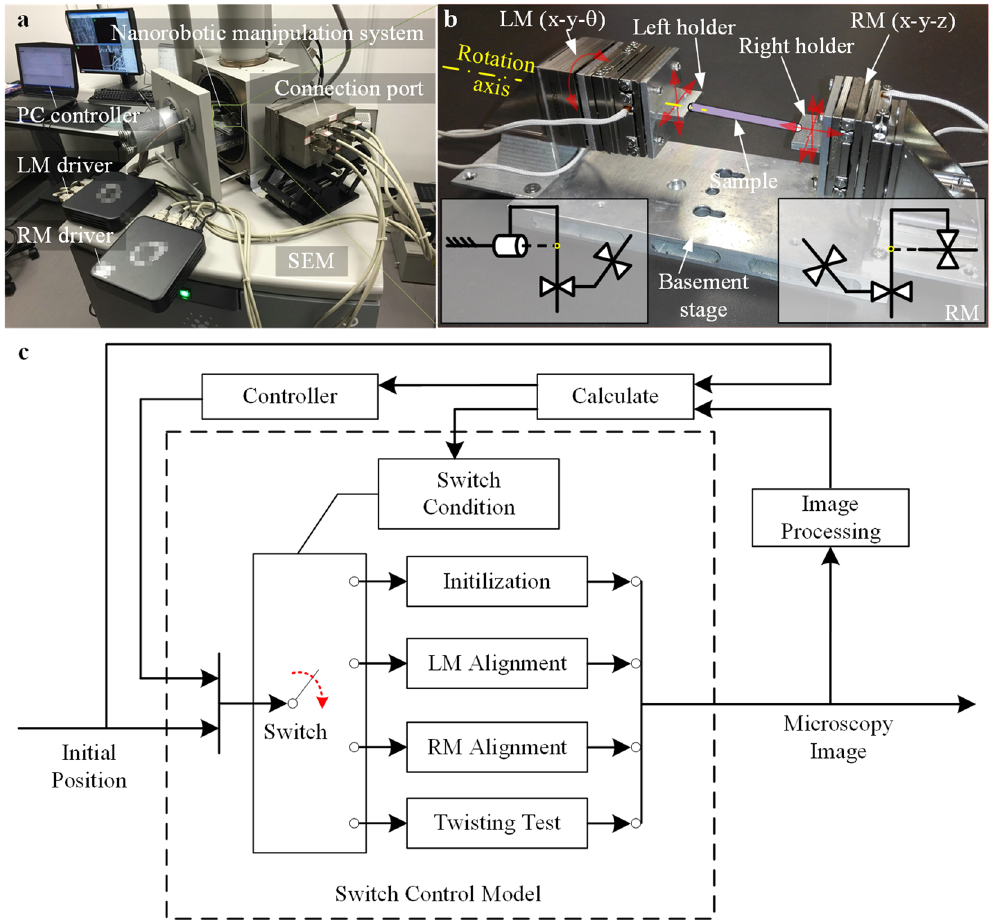
Figure 1. Illustration of the developed iTRo system. ( a ) Overview of system setup. The robot is assembled inside SEM chamber. The PC controller and motor drivers communicate with the robot through a self-designed connection port. ( b ) Image of iTRo. It consists of two independent manipulation units, i.e, LM (x-y- θ ) and RM (x-y-z). The two ends of the sample are fixed on the holder of LM and RM respectively. ( c ) Switch control strategy. There are four steps for a fully twisting test process, i.e., initialization, LM alignment, RM alignment and twisting. In each step, SEM image is captured in real time firstly. Then, the position information of the sample and robot is obtained by image processing. After that, proper control signals are send to each nanopositioner to drive the